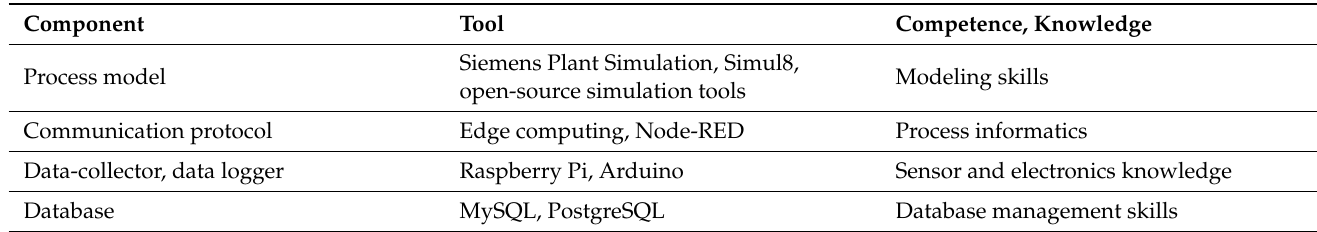
Table 4. The required components and tool competencies for process simulation.